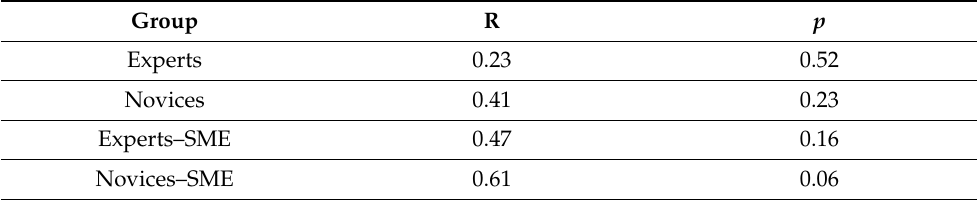
Table 2. Correlations between the MEF and LIK values of the pilots.